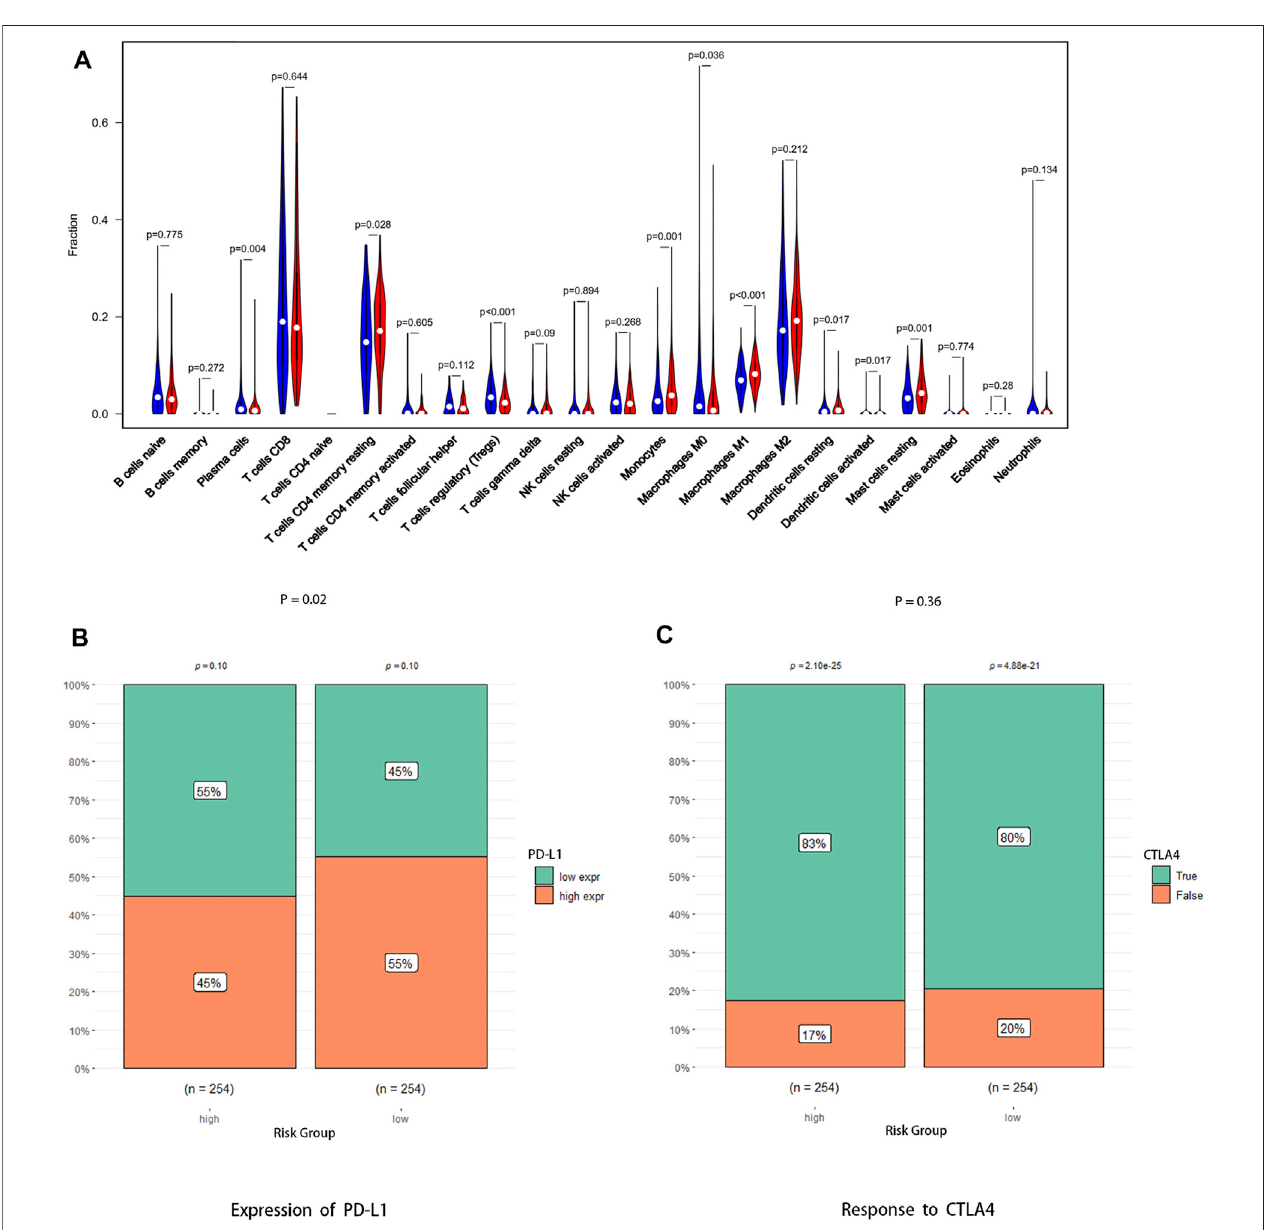
FIGURE 7 | Association between the risk signature and antitumor immune response. (A) Abundance ratio matrix of 22 immune cells in the high-risk group and the low-risk group. (B) Expression level of PD-L1 between the two groups. (C) Response to anti-CTLA4 antibody between the two groups.